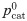
Time-lapse snapshots of the simulated congression process for different values of the rate of MT catastrophes pcat0.Large values of pcat0, that is, overexpression of MT depolymerases, lead to unsuccessful congression. The nuclear envelope is shown for reference in each of the first panels as a white sphere. The cortex is represented in dark grey.